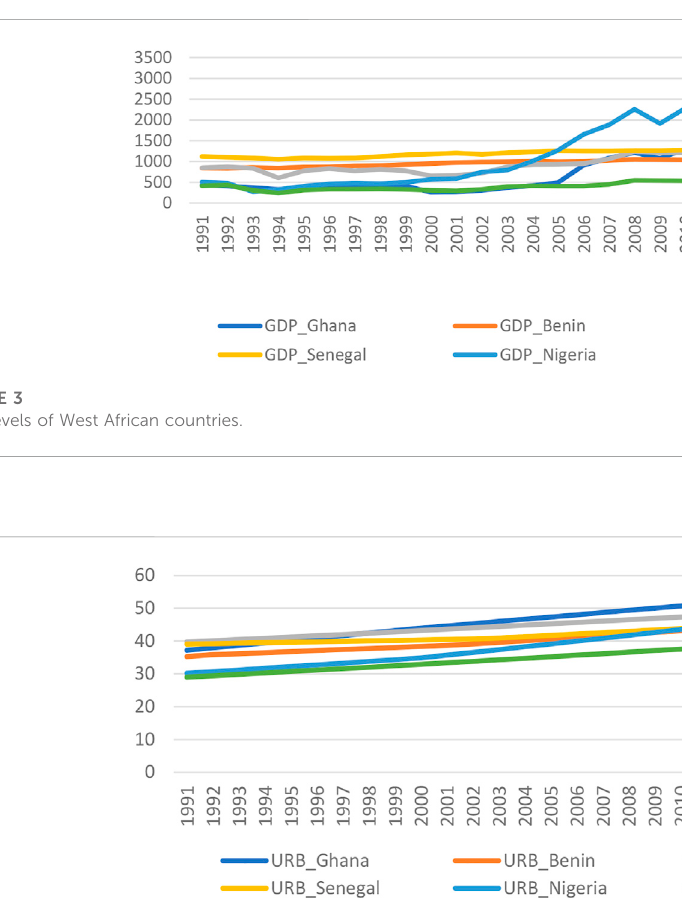
FIGURE 4 Urbanization rate levels of West African countries.